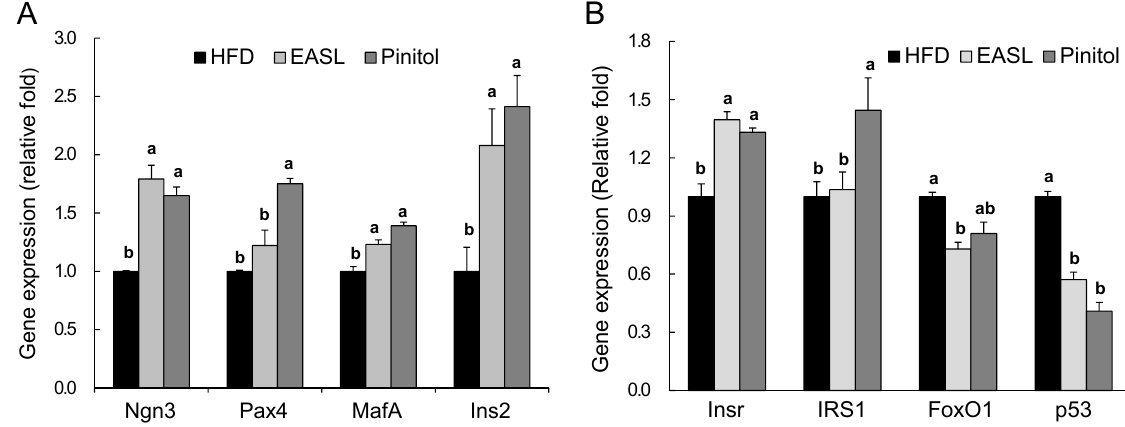
Figure 3. Effects of EASL supplementation on the relative mRNA expression levels of pancreatic genes related to β -cell development ( A ) or insulin sensitivity ( B ). The levels of mRNA in pancreatic tissue were measured by real-time quantitative RT-PCR (qRT-PCR) and normalized to glyceraldehyde-3-phosphate dehydrogenase ( GAPDH ) expression. Values are presented as mean ± SE. a,b Means not sharing a common letter are significantly different between groups ( p <